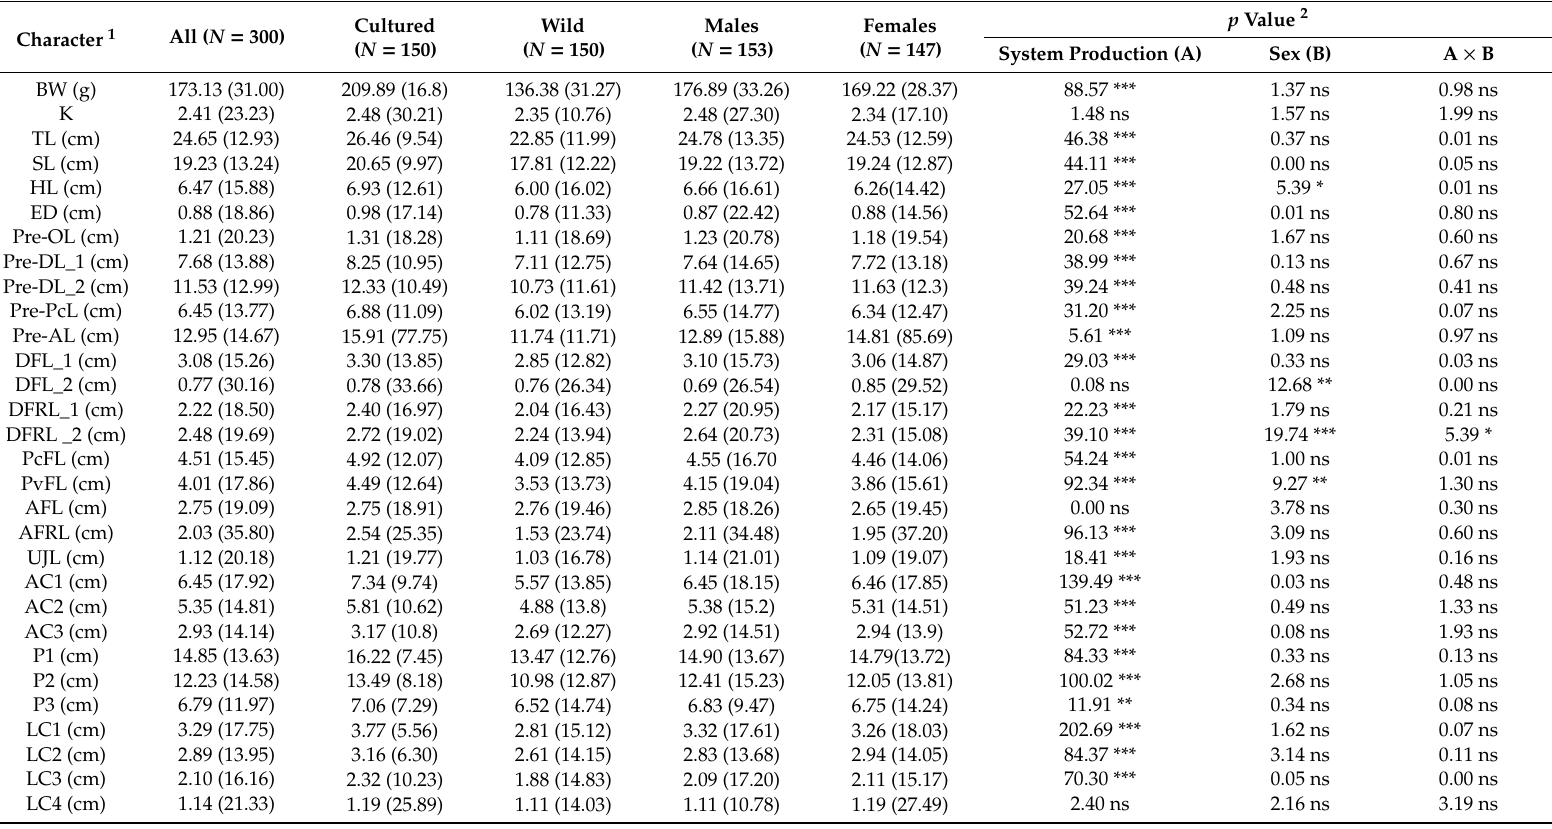
Table 2. Descriptive statistics of body measurements (original data) of Dormitator latrifrons from hatchery and wild populations for each sex (mean